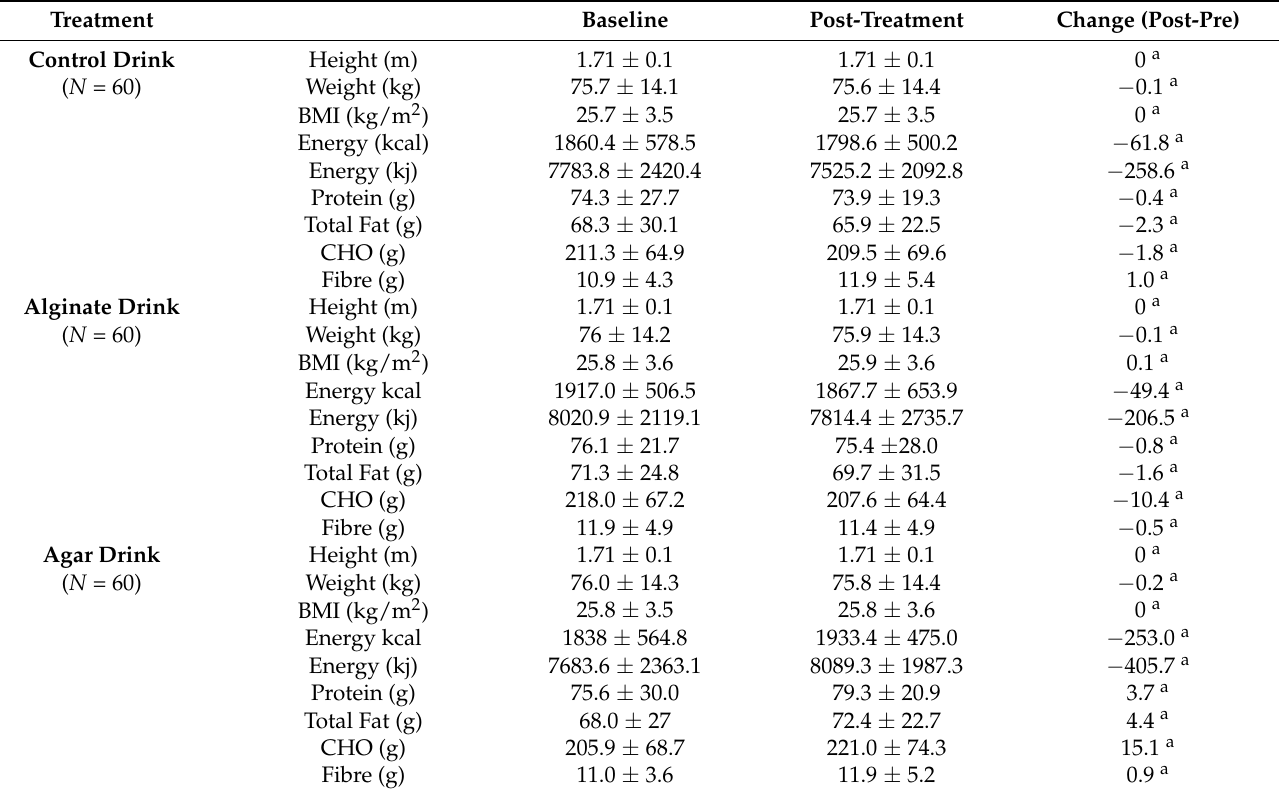
Table 2. Anthropometric measurements and habitual dietary intake by